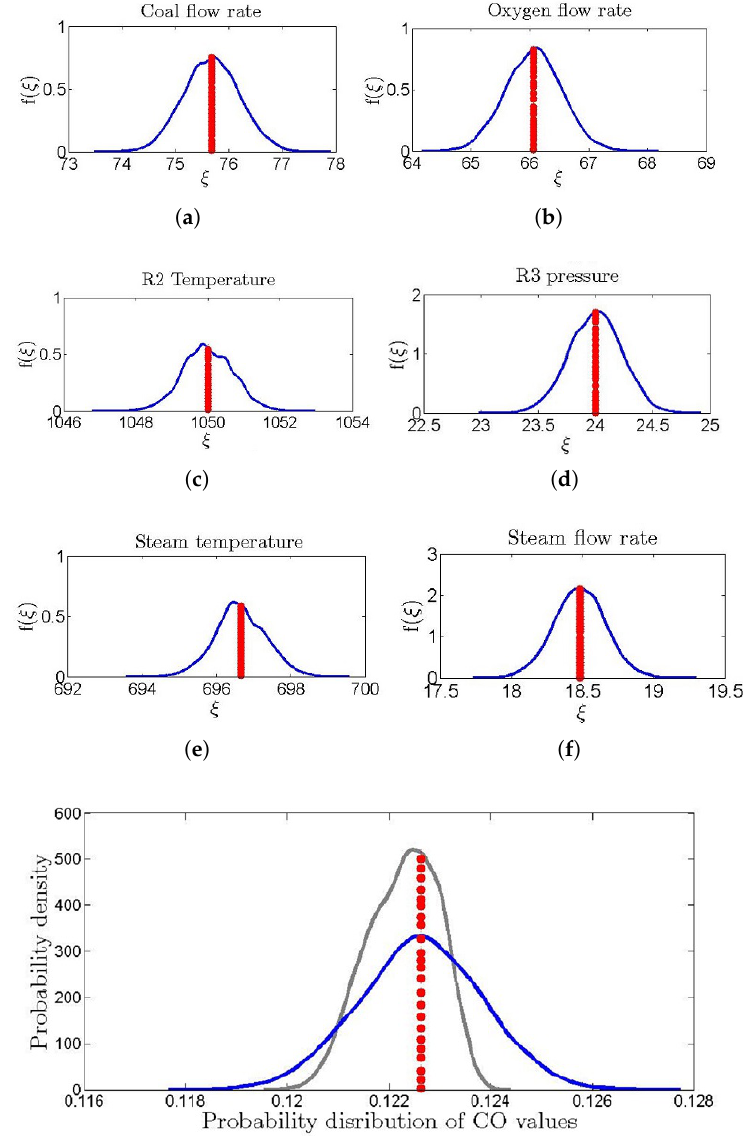
Figure 8. ( a – f ) Polynomial chaos expansion (PCE)-based predicted distribution of input variables (blue) and measured value of entrained flow coal gasification (red dotted lines), ( g ) PCE-based derived distribution of measured CO values (blue), non-intrusive PCE-based predicted distribution of CO (grey) and measured value of CO (red dotted